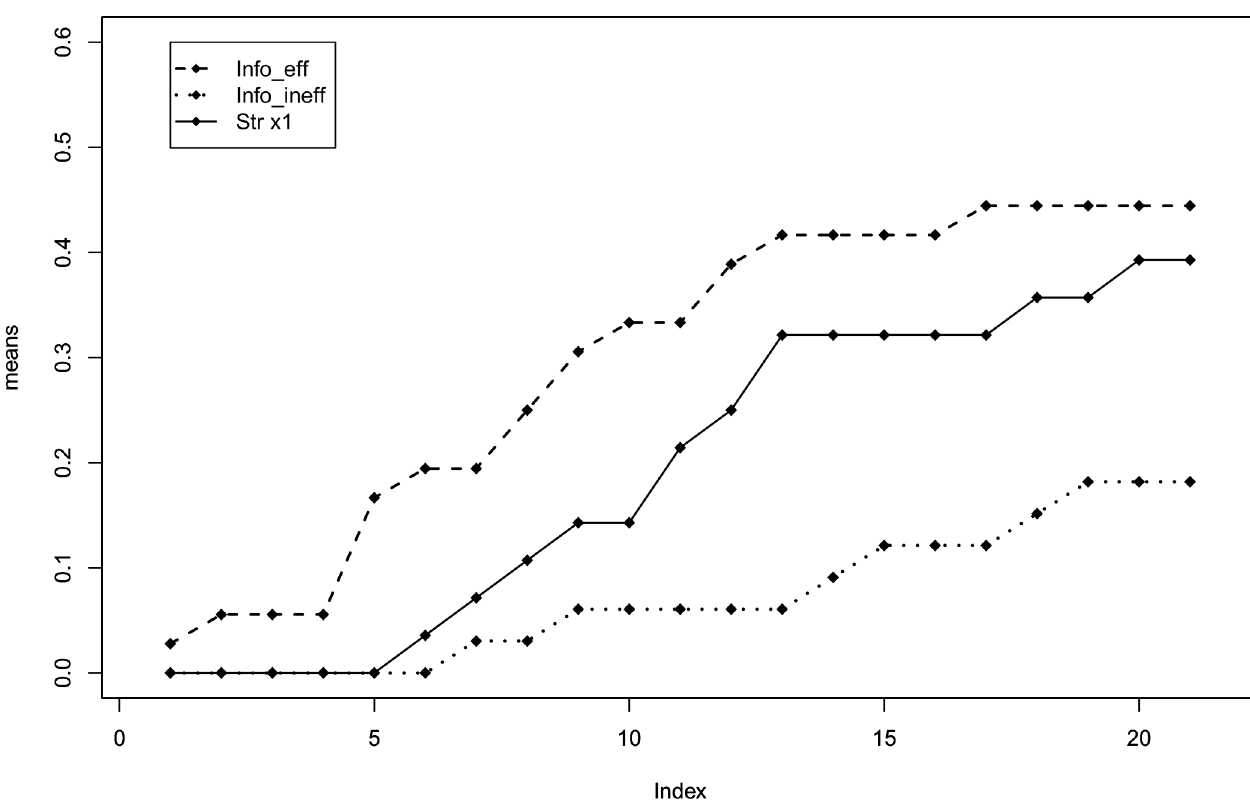
Fig 6. Fraction of efficient choices by round and